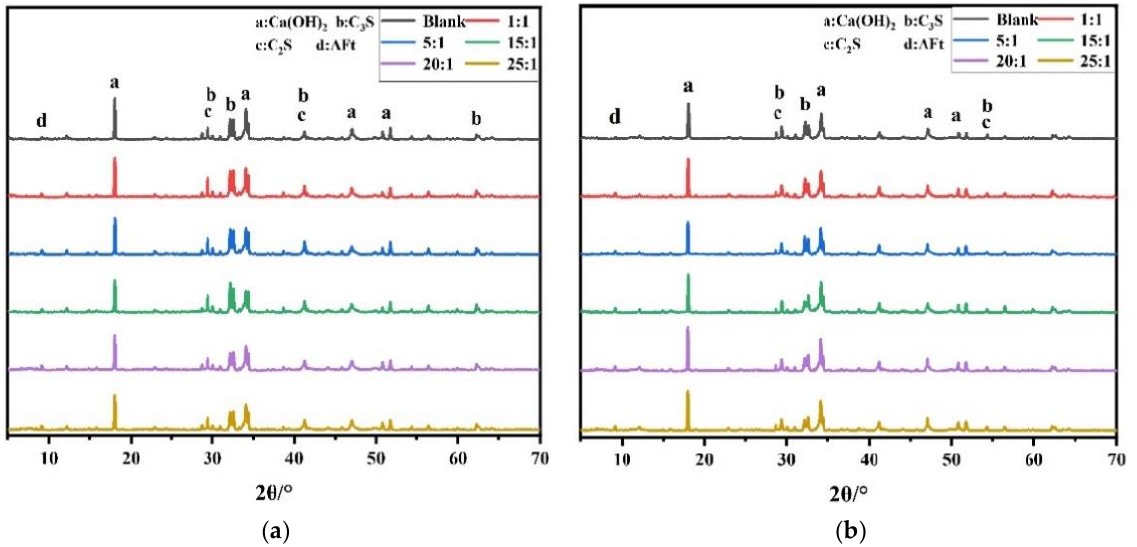
Figure 11. XRD patterns of cement pastes with or without PBA-g-PDMAEMA at: ( a ) three days; ( b ) seven days.